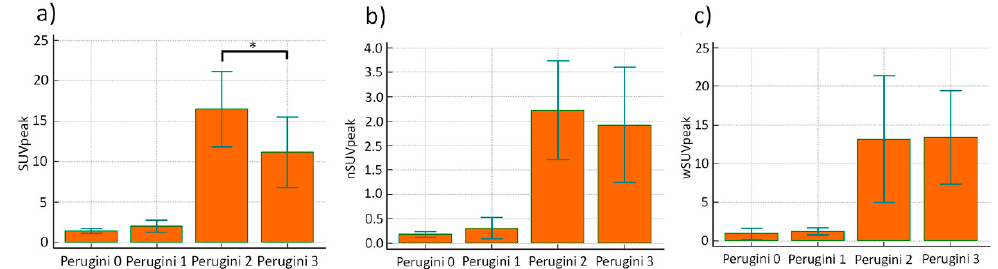
Figure 3. Comparison of SUVpeak, nSuvpeak and wSUVpeak values for Perugini grades 0–3: ( a ) SUVpeak was significantly increased in patients with Perugini grade 2 compared to 3 (* p = 0.0011), whereby the standard deviation of around 50% has to be taken into consideration, so that the significance might disappear with higher patient numbers; ( b ) nSUVpeak showed no significant differences between both values ( p = 0.531); ( c ) wSUVpeak also showed no significant differences between Perugini grade 2 and 3 ( p = 0.95).